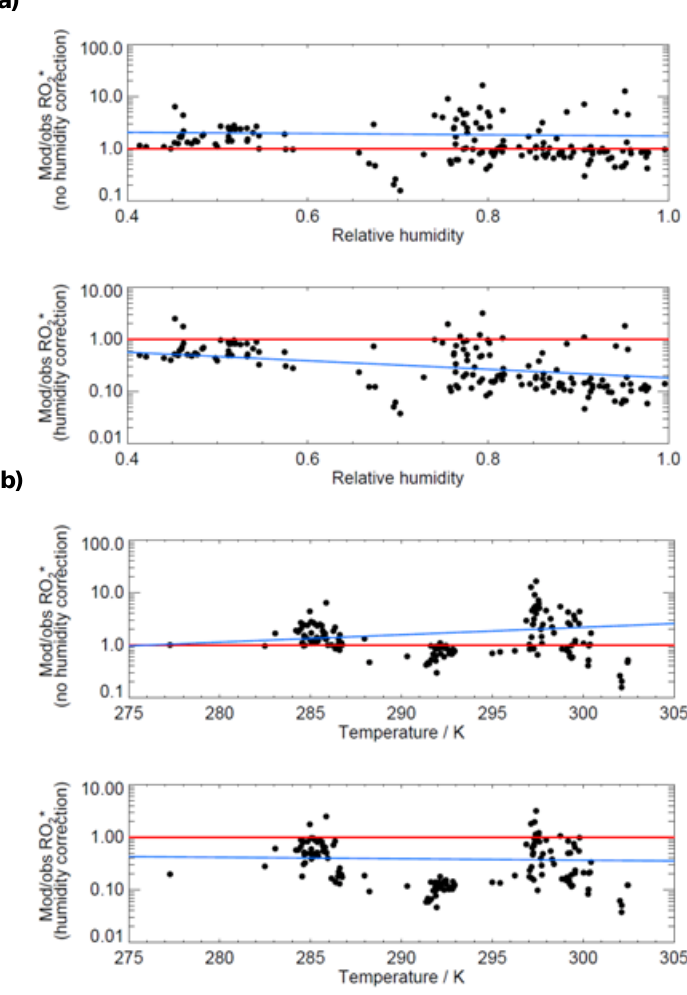
Fig. 4. DSMACC model to PERCA 4 measurement ratio as a function of relative humidity (as a fraction).